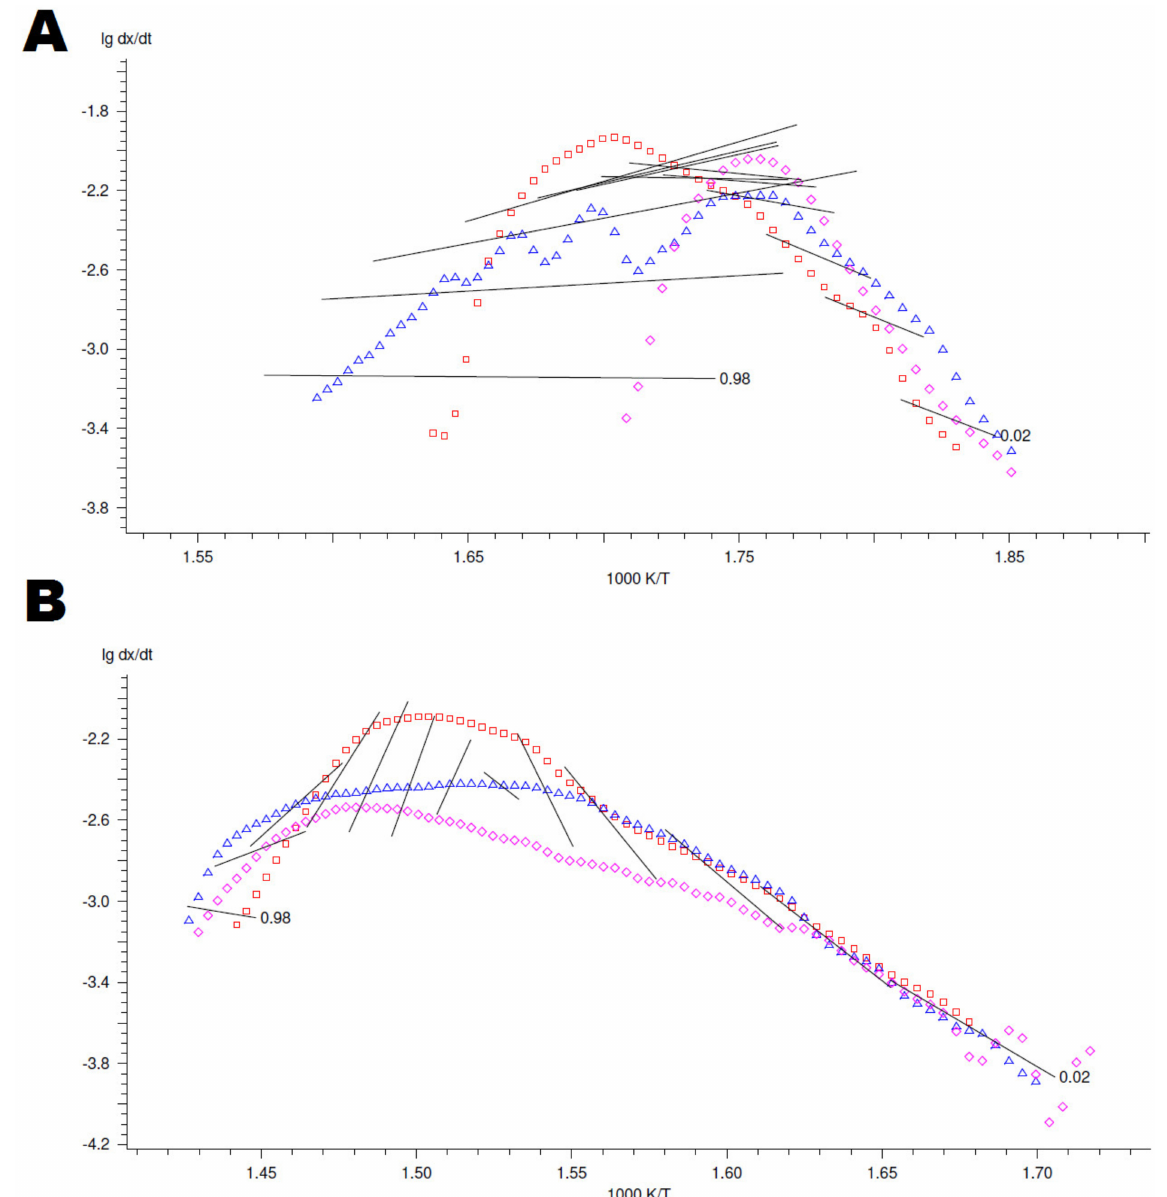
Figure A5. Friedman POM-O analysis plot lg (reaction rate) vs. 1000 K/T: ( A ) sample investigated in an oxygen atmosphere; ( B ) sample investigated in an inert atmosphere. Lines are drawn through isoconversion points for the measurement with 10 ( ♦ ), 15 ( ∆ ), and 20 ( (cid:3) ) ◦ C/min heating